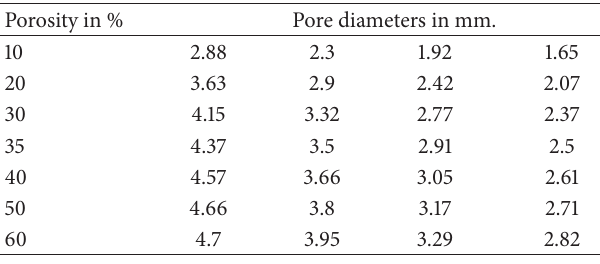
Table 1: Pore diameters (in mm) of 3D porous beam models used for different porosity percentages. Porosity in % Pore diameters in mm.